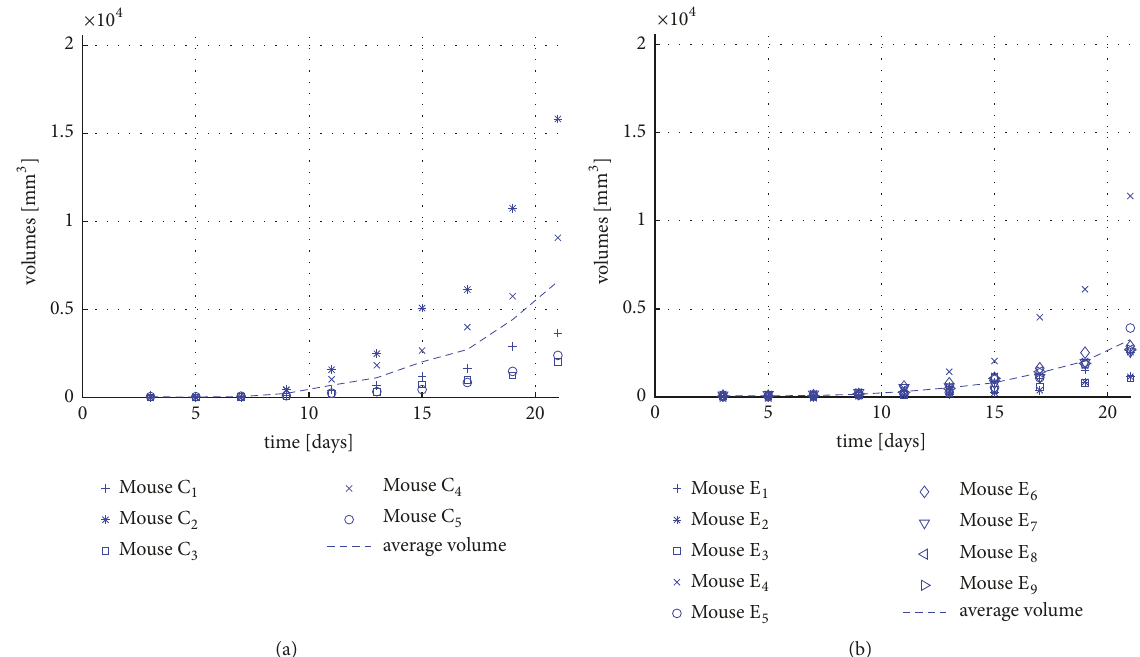
Figure 2: (a) The measured tumor volumes for mice C1-C5 that received therapy 1 and their average. (b) The measured tumor volumes for mice E1-E9 that received therapy 2 and their